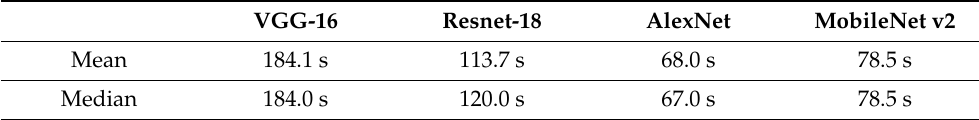
Table 7. Training Times for Various